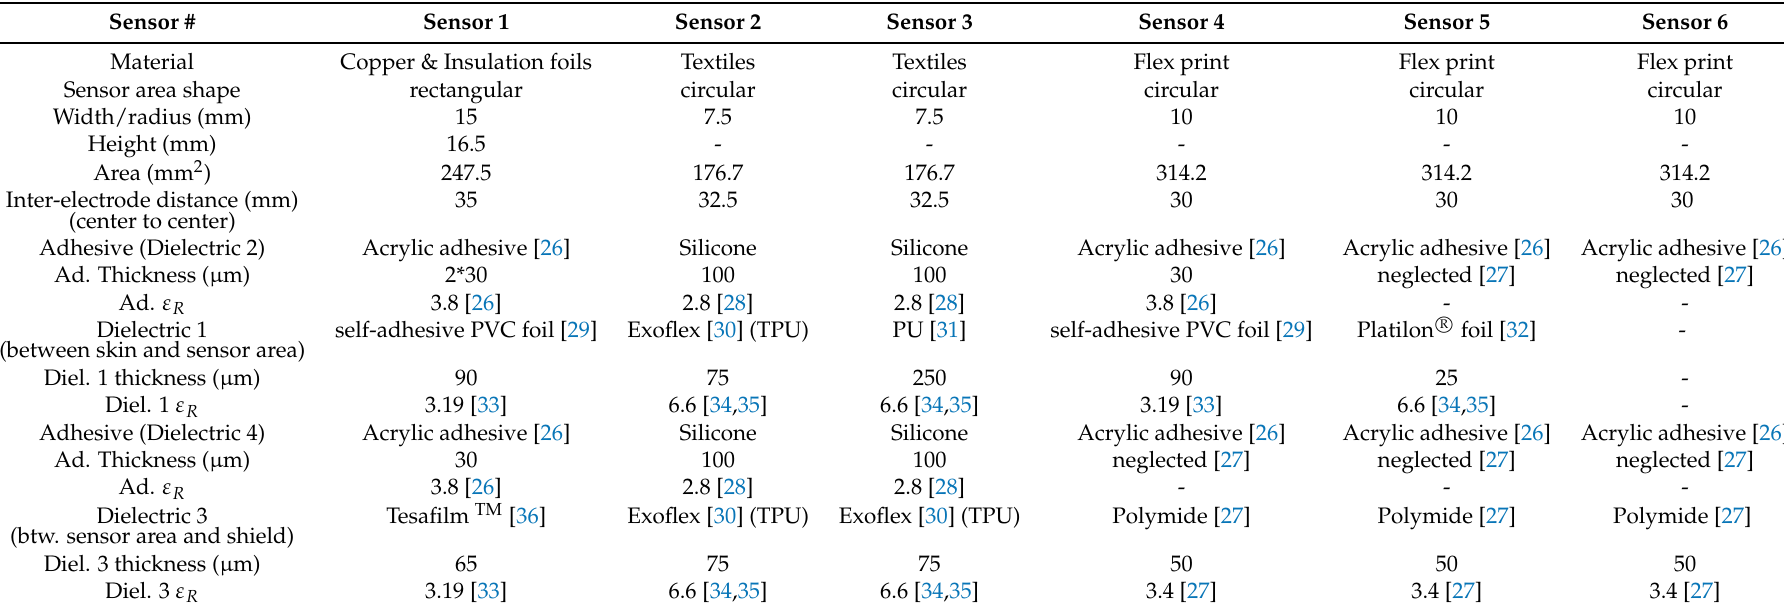
Table 1. Parameters of sensor